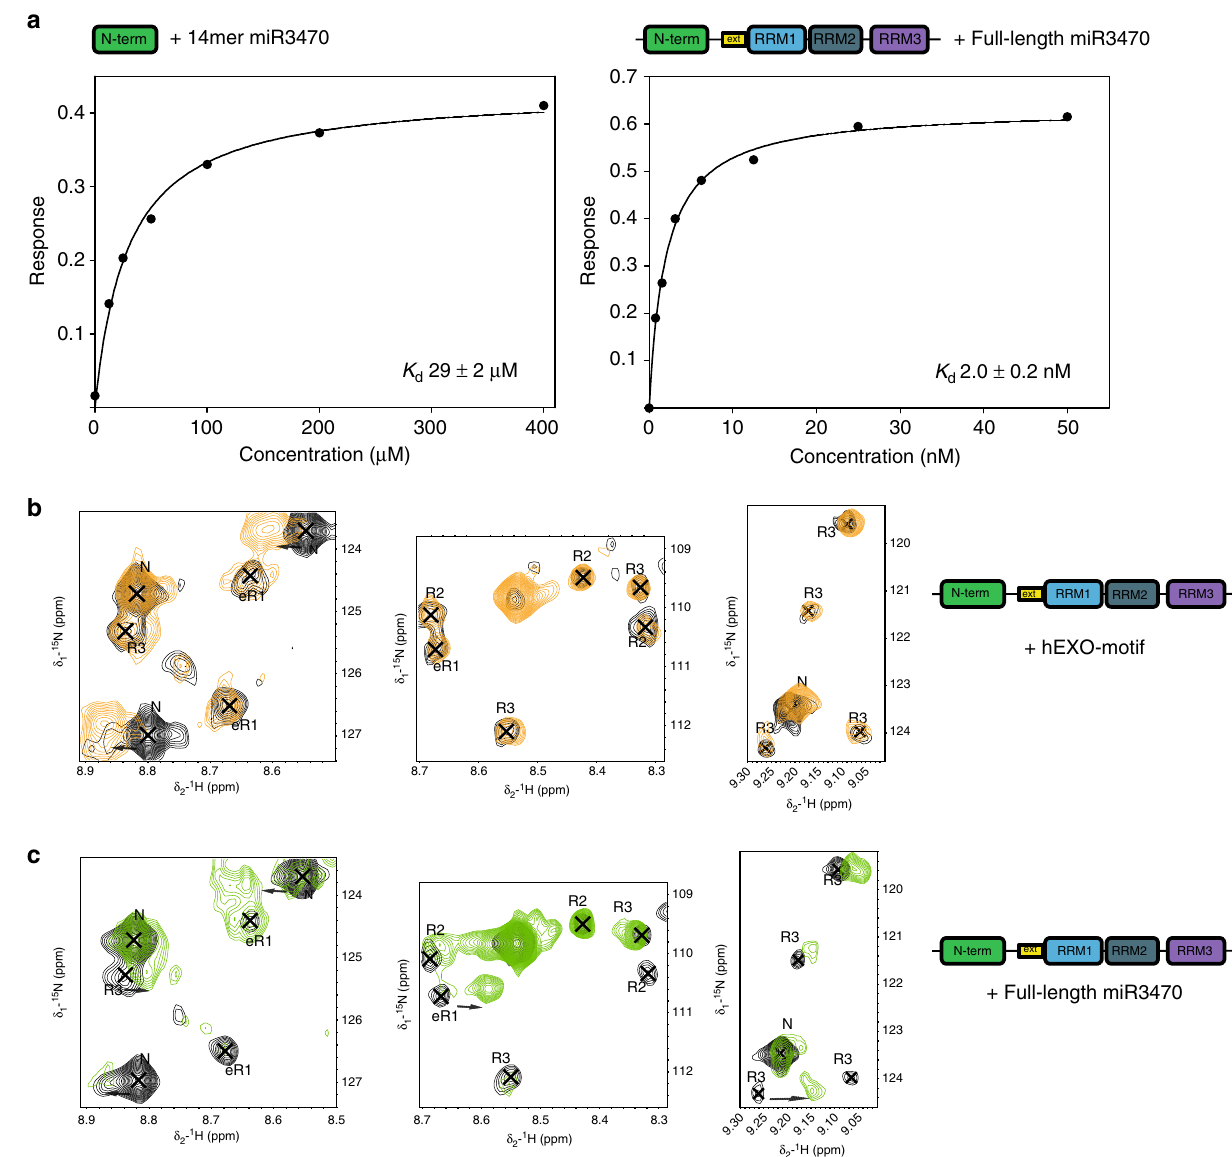
Fig. 9 The three RRM domains of Syncrip participate in and are required for the speci fi c high-af fi nity interaction between Syncrip and miR-3470. a Binding of the human Syncrip N and NeR1R2R3 proteins to a 14mer miR-3470 RNA (left) and to a full-length miR-3470 (right), monitored by BLI. The BLI response values are plotted against protein concentration, fi tted isotherms are shown as continuous lines. b Expanded view of three well dispersed regions of the HSQC spectrum of human Syncrip NeR1R2R3. The free spectrum (black) is superimposed with that of the protein bound to the AGGCU hEXO-motif at 1:1 ratio (orange). Upon addition of the RNA, resonances belonging to the NURR domain RNA-binding surface shift, while resonances of the RRM domains are not perturbed. Peaks are labelled according to the domain the residue locates to. c Expanded view of HSQC spectrum as in b , but employing full-length miR-3470. Upon addition of the RNA, resonances from all four domains are perturbed demonstrating their involvement in